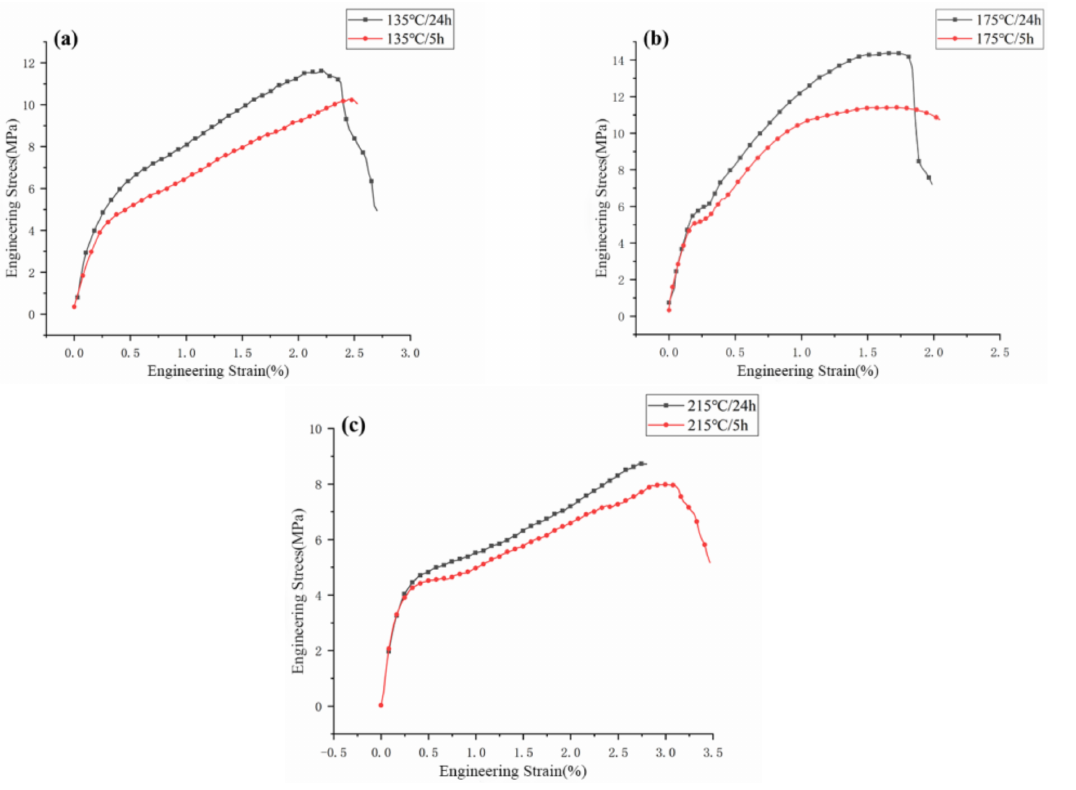
Figure 11. Average flexural stress vs. deformation of specimens after baking at ( a ) 135 ◦ C, ( b ) 175 ◦ C, and ( c ) 215 ◦ C.